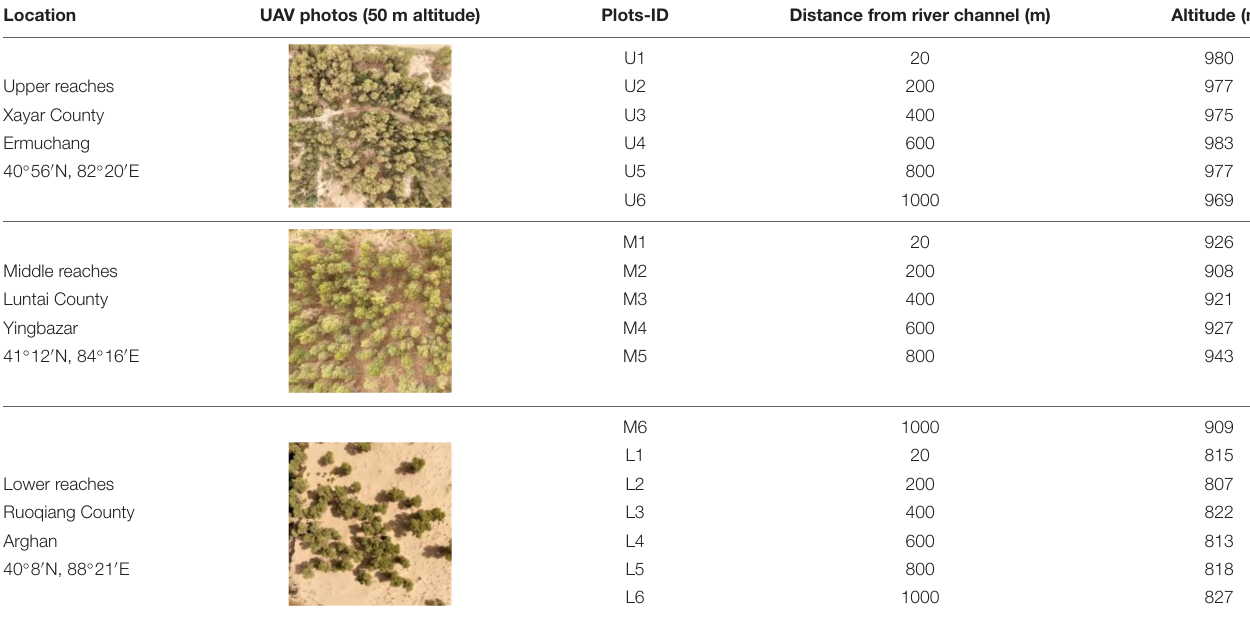
TABLE 1 | Basic information of the P. euphratica forest plots. Location UAV photos (50 m altitude) Plots-ID Distance from river channel (m) Altitude (m) U1 20 980 Upper reaches U2